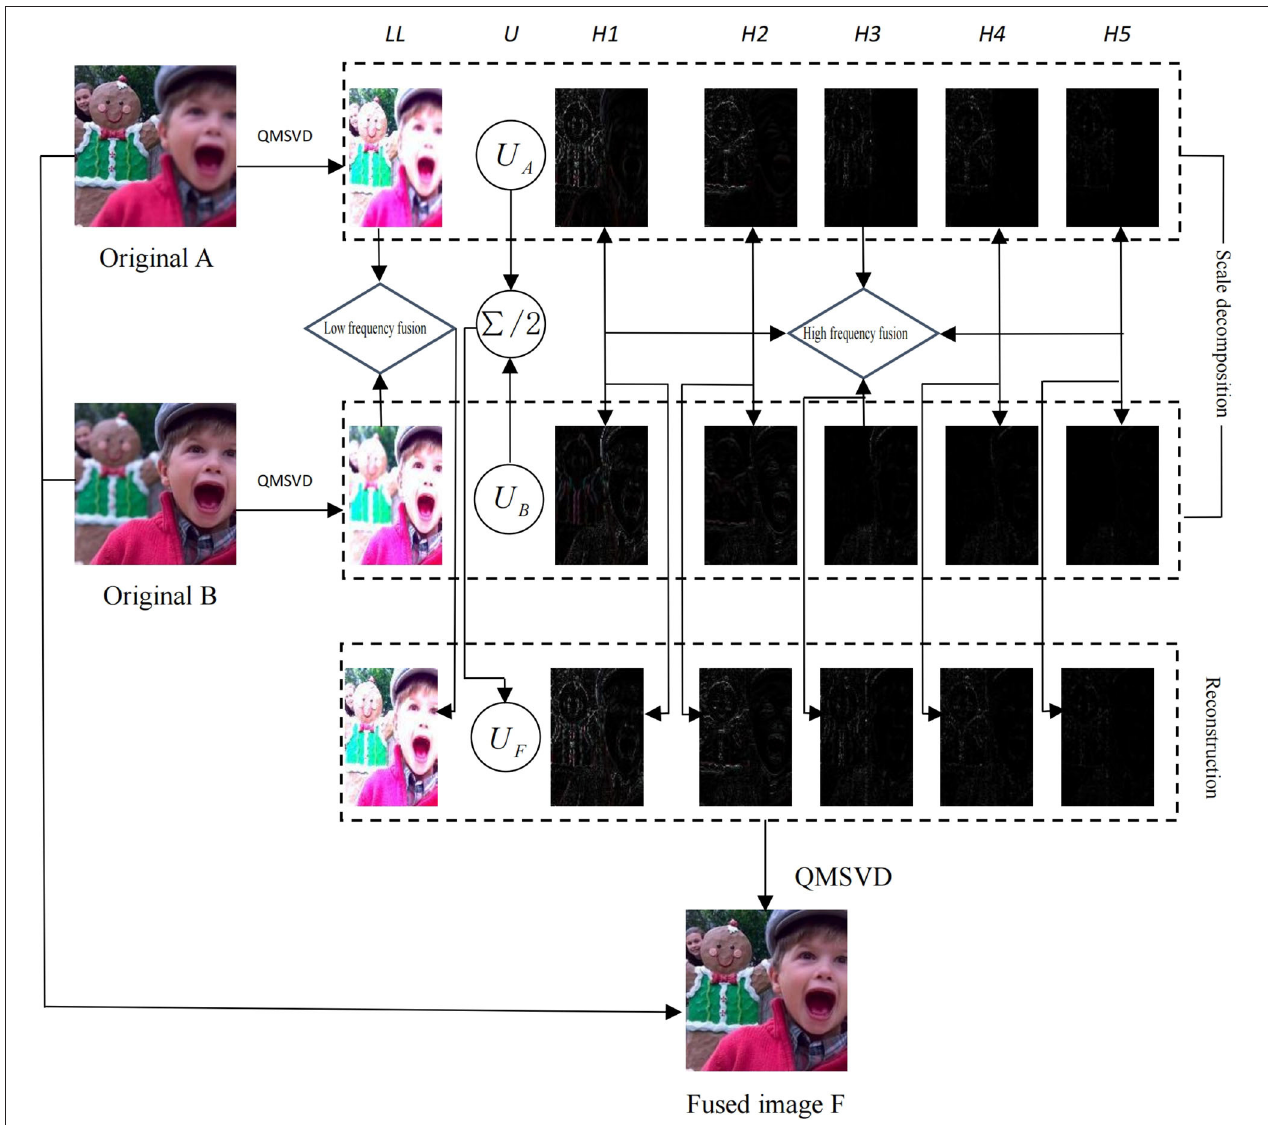
FIGURE 2 | Fusion of sub-images by QMSVD with six channels. LL is the low-frequency component of the decomposed image, H1–H5 are the high-frequency components of the decomposed image, U A and U B are the orthogonal matrices of the decomposed image, and U F